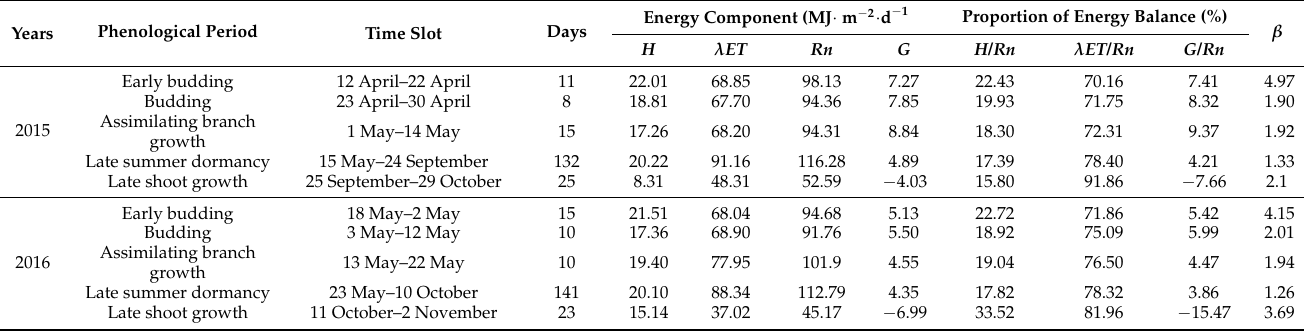
Table 5. The change in energy flux during the phenophase of H. ammodendron in 2015–2016. R n is the net radiation, λ ET is the latent heat flux, H is the sensible heat flux, and G is the geothermal